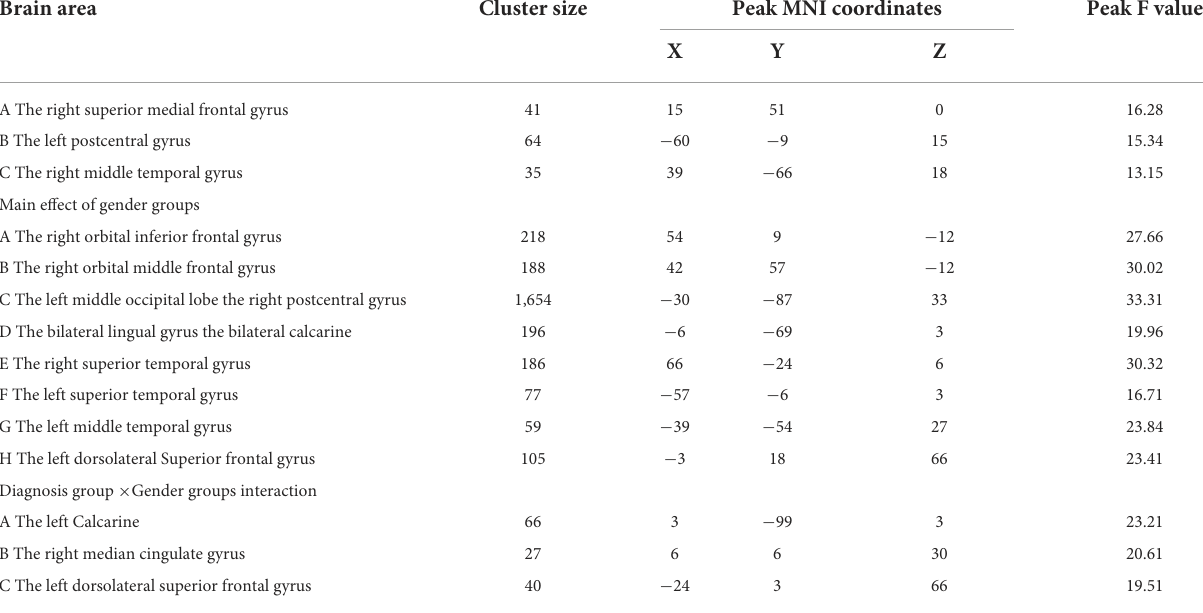
TABLE 4 Clusters exhibiting the influence of male and female sex on ReHo in the MDD and HC